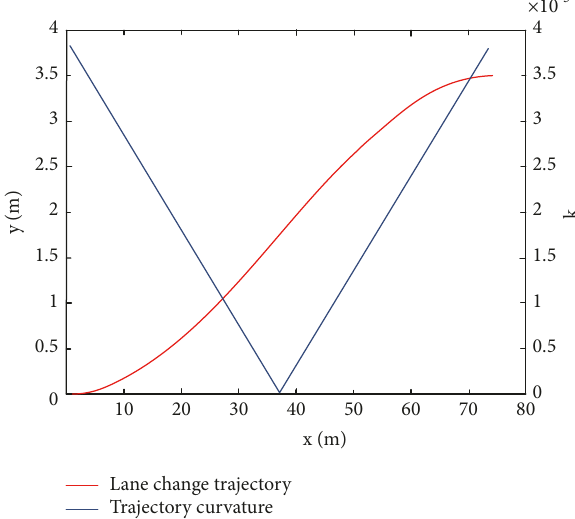
Figure 3: Trajectory and corresponding curvature change